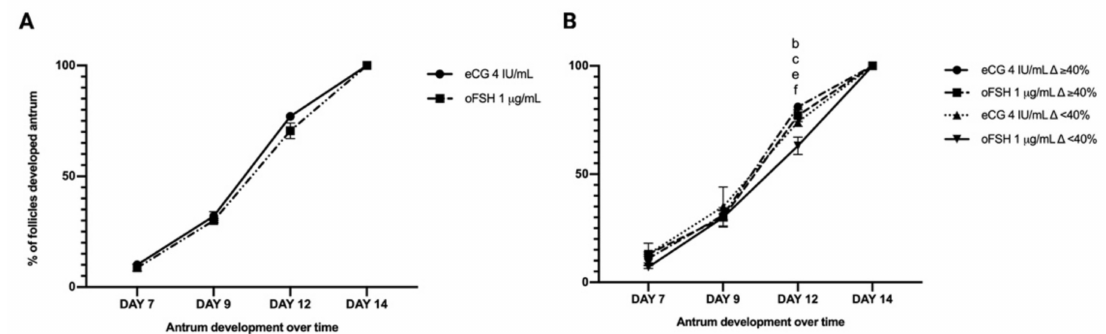
Figure 2. Development trend of the follicular antrum overtime. Antrum formation over time ( A ) and antrum formation overtime according to follicle ∆ growth % ( B ) following eCG and oFSH stimulation. Letters indicate significant differences between: eCG 4 IU/mL ∆ ≥ 40% vs. oFSH 1 ug/mL ∆ ≥ 40%; b eCG 4 IU/mL ∆ ≥ 40% vs. eCG 4 IU/mL ∆ < 40%; c eCG 4 IU/mL ∆ ≥ 40% vs. oFSH 1 ug/mL ∆ < 40%; e oFSH 1 ug/mL ∆ ≥ 40% vs. oFSH 1 ug/mL ∆ < 40%; f eCG 4 IU/mL ∆ < 40% vs. oFSH 1 ug/mL ∆ < 40%. Three independent biological replicates were performed. For each biological replicate, 66, 67, and 67 follicles per group (eCG 4 IU/mL and oFSH 1 µ g/mL) were cultured.